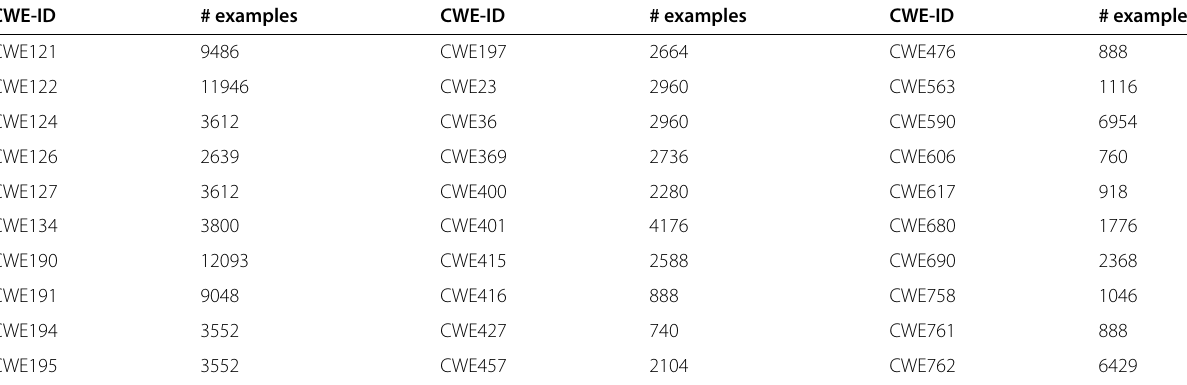
Table 2 In this table we provide total counts of binary executables for each of the CWE-IDs we studied in the Juliet Test Suite